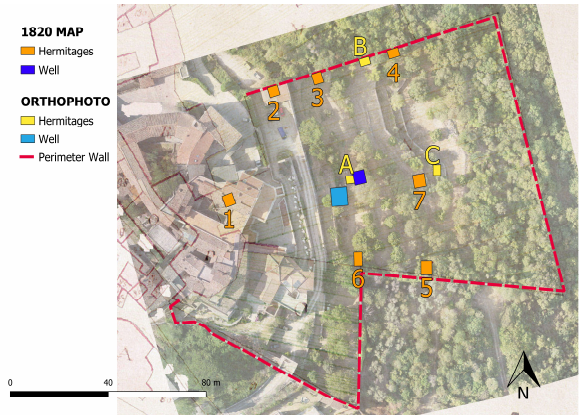
Figure 9 . Comparison between hermitages positions.